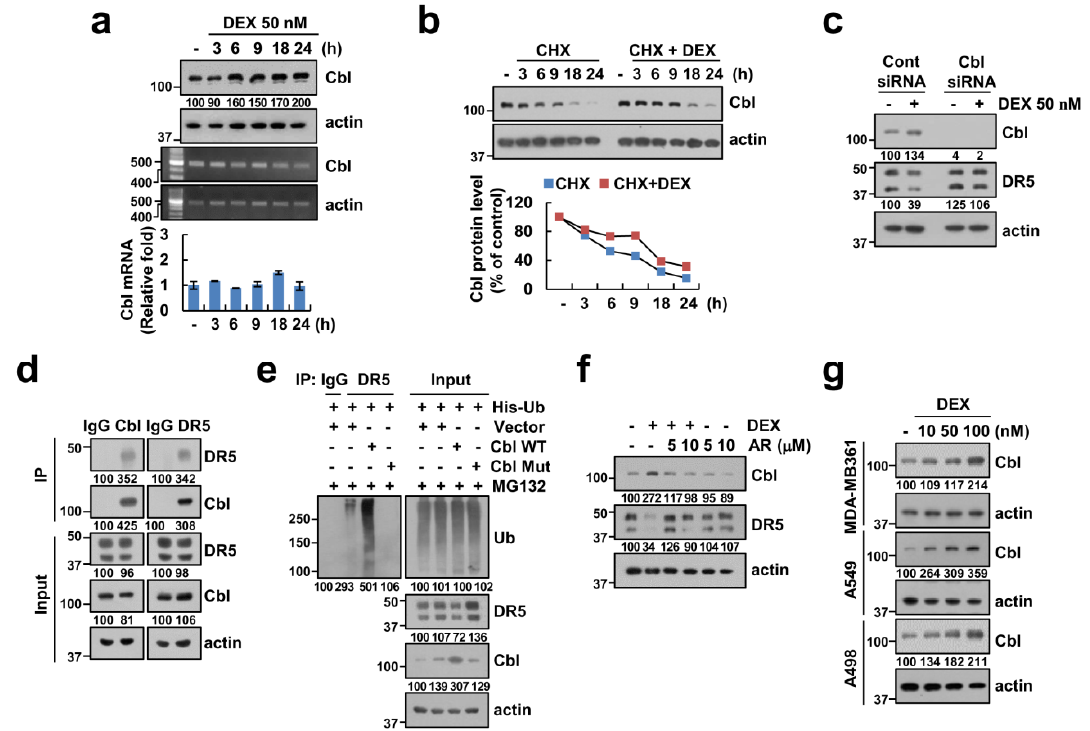
Figure 6. DEX increases ubiquitination of DR5 via upregulation of Cbl expression. ( a ) Caki-1 cells were treated with 50 nM DEX for the indicated time periods. ( b ) Cells were treated with 20 µ g / mL CHX in presence or absence of 50 nM DEX for the indicated time points. ( c ) Caki-1 cells were treated with 50 nM DEX for 24 h. ( d ) The interaction with Cbl and DR5 was indicated by immunoprecipitation (IP) assay. ( e ) Caki cells were treated with 0.5 µ M MG132 for 12 h. ( f ) Caki-1 cells were pretreated with GSK-3 β inhibitor (AR-A014418) for 1 h, and then treated with 50 nM DEX for 24 h. ( g ) We used the same lysates in Figure 2b. Protein and mRNA expression were measured by Western blotting ( a – g ) and RT-PCR or qPCR ( a ), respectively. Band intensity of Cbl was analyzed using ImageJ. Values in the graphs ( a ) represent mean ± SD of three independent experiments. Uncropped pictures of the western blot shown in the Supplementary Figure 8.